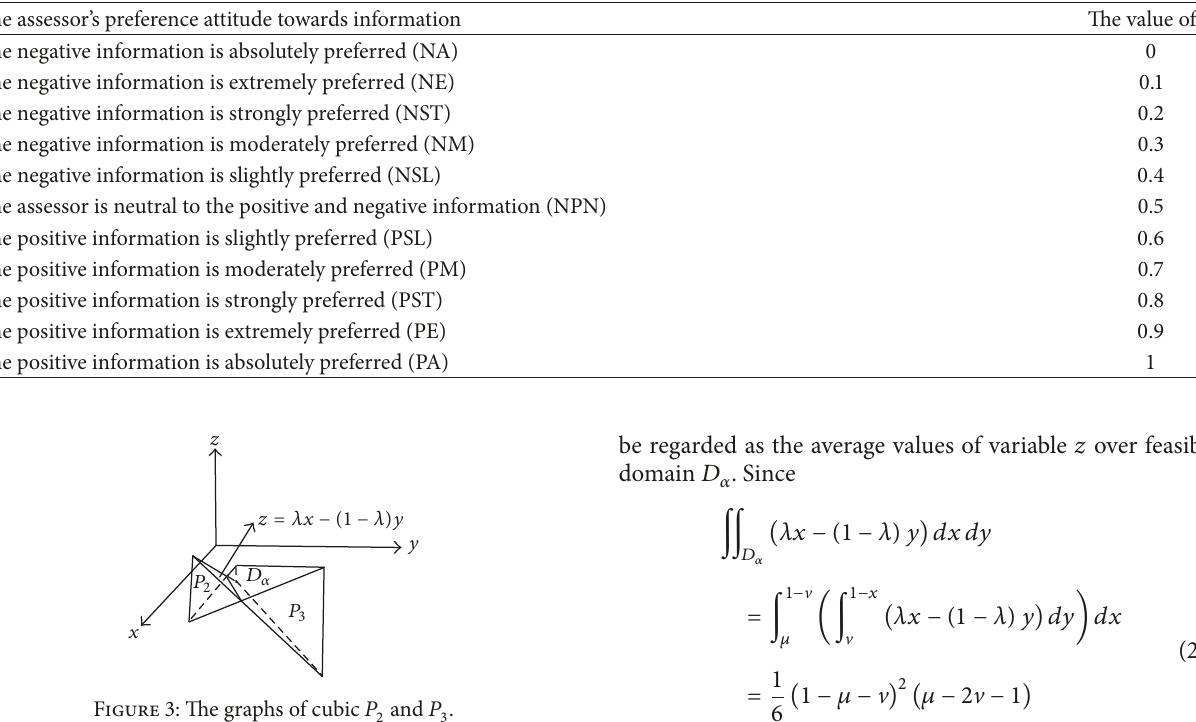
Table 1: Preference attitude towards information and the corresponding value of 𝜆 .